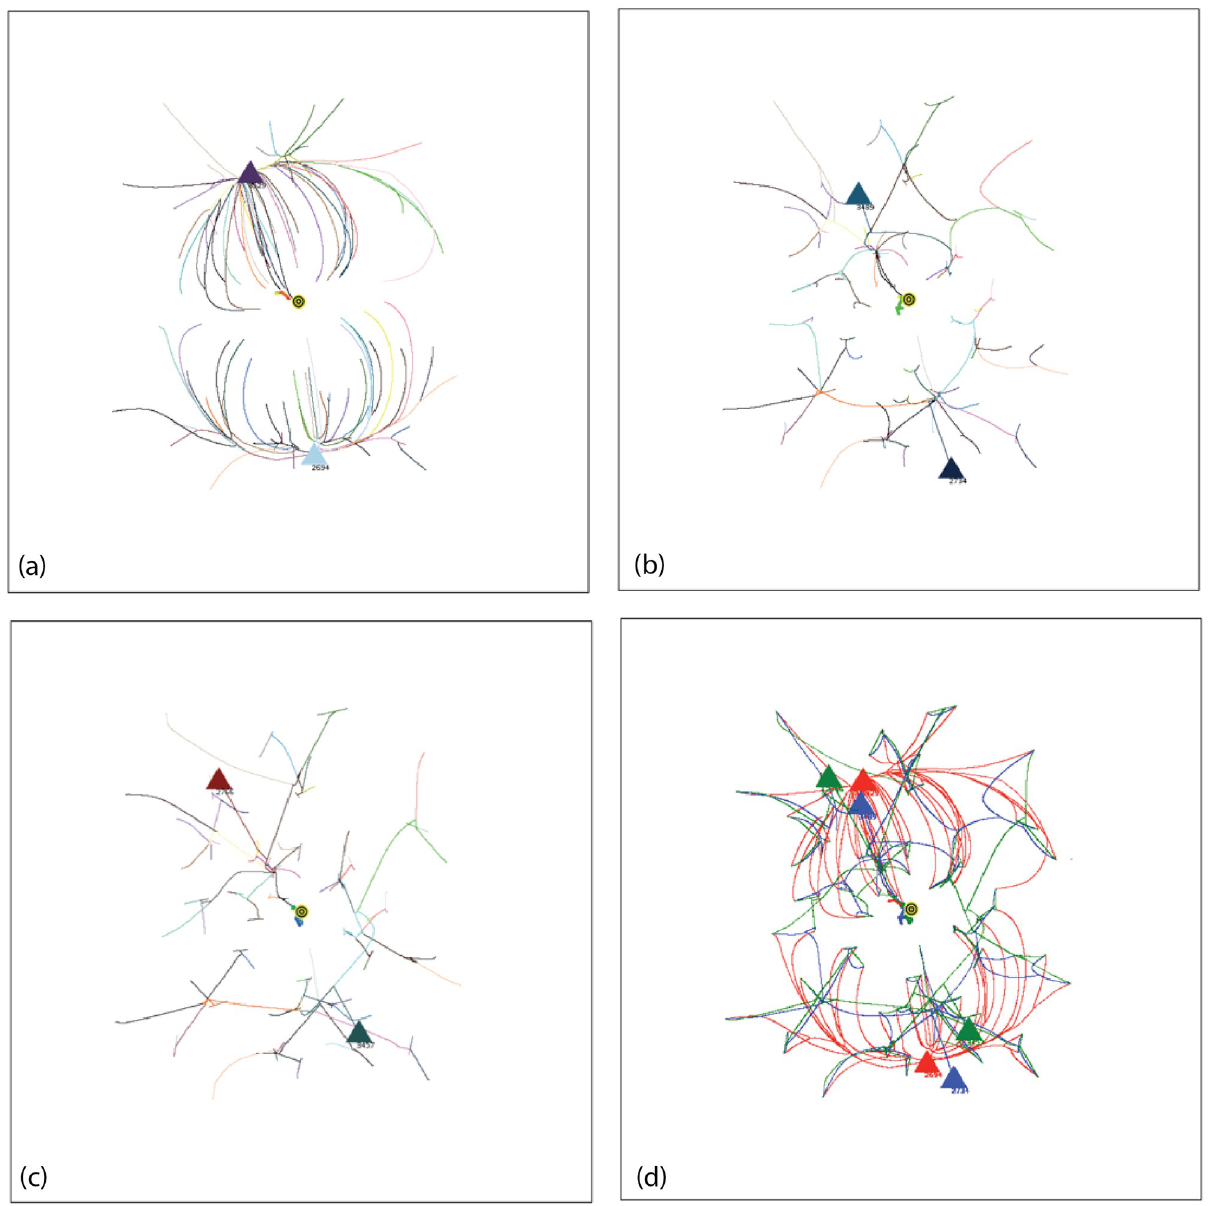
Fig 6. Simulations for the same FVM force vector law but with three values of the force exponent, with AIB = 100, seed 91. (a) 1/ r 0.5 . ET = 503, DT � 0.5. (b) 1/ r 2 . ET = 23, 360, DT � 100. (c) 1/ r 5 . ET = 1.3 × !0 7 , DT � 1.28 × 10 7 . (d) Overlay of tracks from all three simulations with red r 0.5 , blue r 2 , green r 5 . The colors of the tracks in a, b and c correspond to the color assigned to each initial agent.